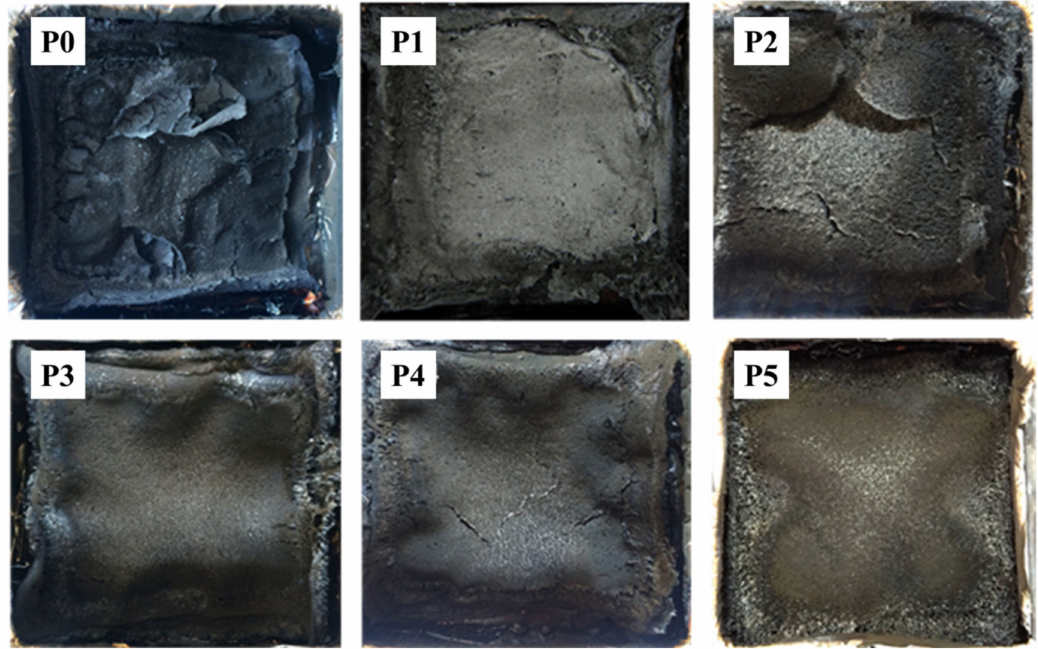
Figure 9. Digital photos of carbon residue after burning of the RPUF